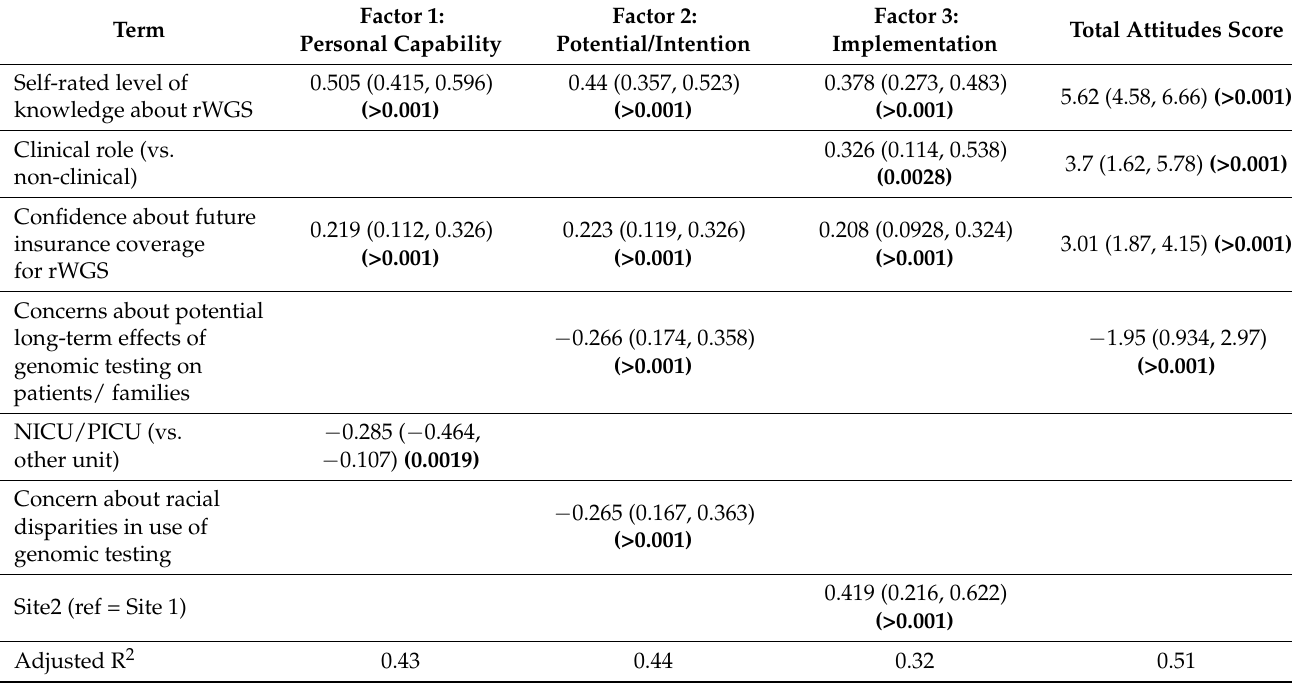
Table 4. Final regression model predicting factors and total rWGS attitudes score (N = 307). Coefficient (95% CI) ( p